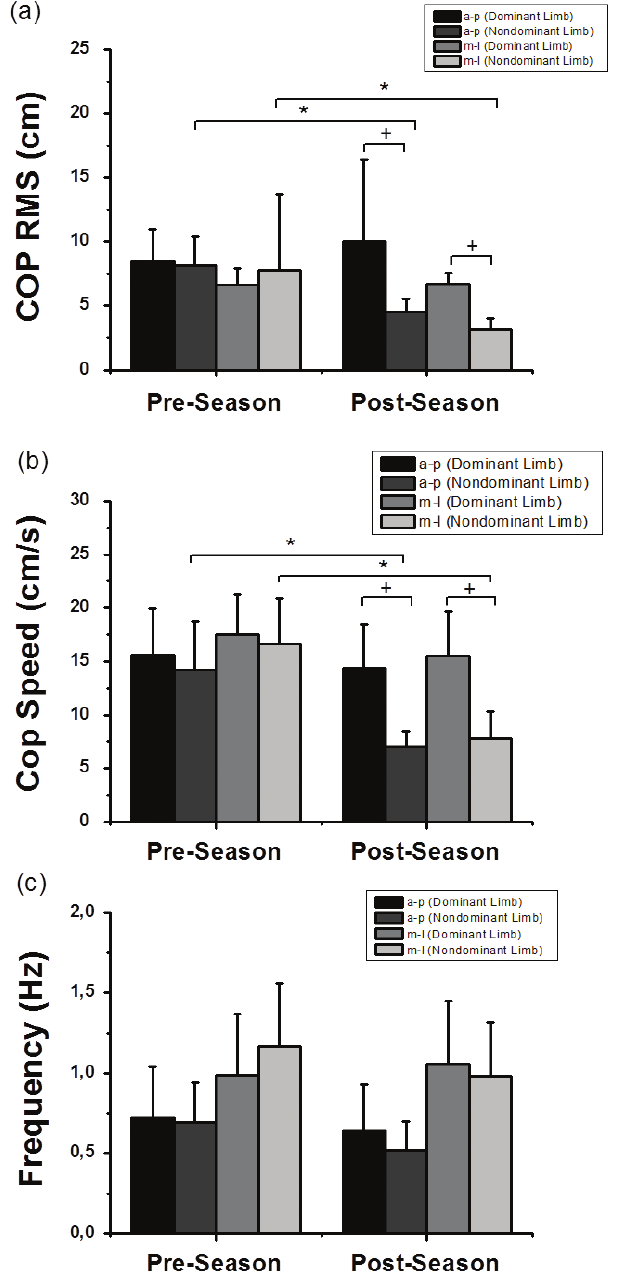
Figure 2. Mean ± SD values for pre- and post-season during unipodal quiet standing of the following analyzed variables: (a) COP RMS (anterior-posterior and medial-lateral directions) (b) COP speed (anterior-posterior and medial-lateral directions) and (c) frequency (anterior-posterior and medial-lateral directions). Note: * indicates difference between season periods, p <0.05; + difference between lower limbs, p